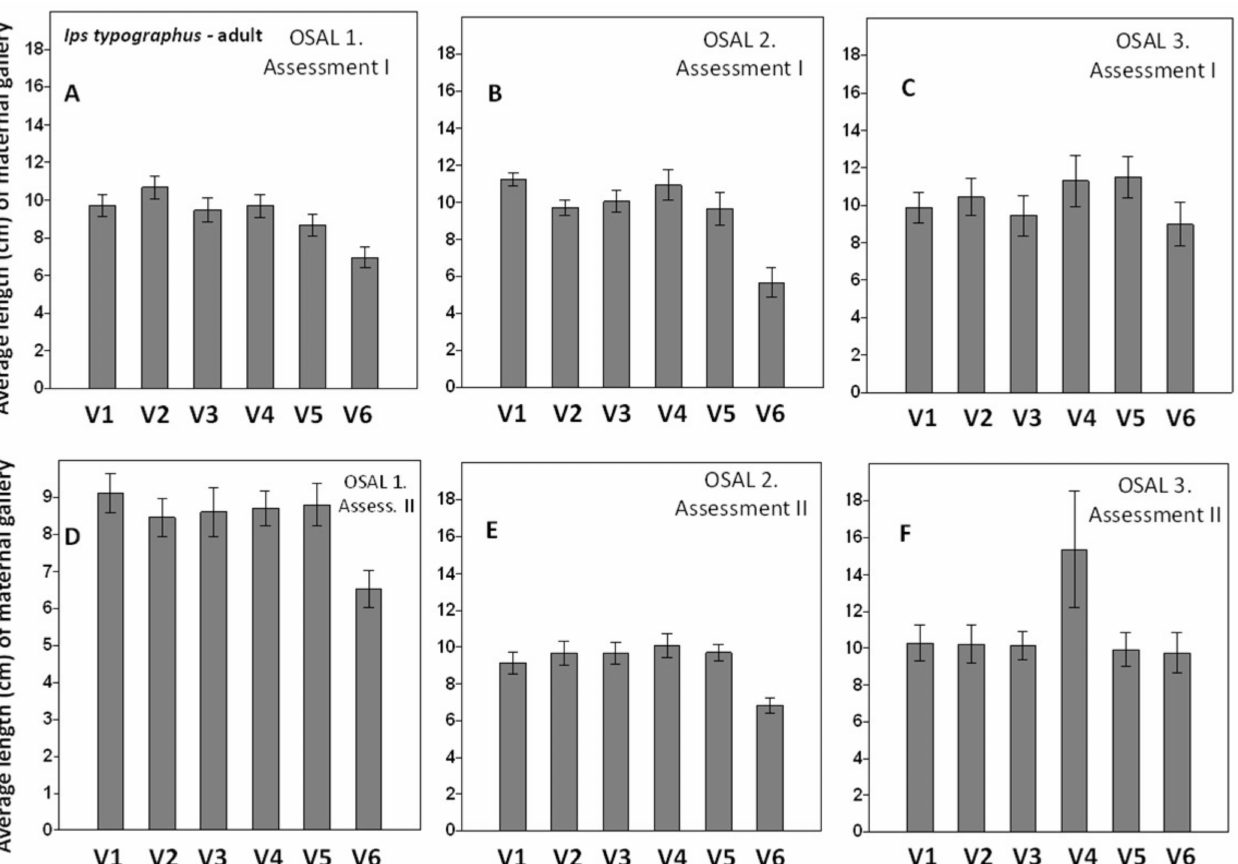
Figure 2. Average length (cm) of the adult I. typographus gallery in the first ( A – C ) and second ( D – F ) assessments: variants V1–V6 (V1, control, sprayed with water; V2, Metab 75 mL/10 L water; V3, Metab 105 mL/10 L water; V4, Metab 135 mL/10 L water; V5, Metab 165 mL/10 L water; V6, lambda- cyhalothrin 50 g/L (Karate Zeon) 50 mL/10 L water). Lines above bars represent standard errors (SE). OSAL is the official name of the Forest Management Agency in